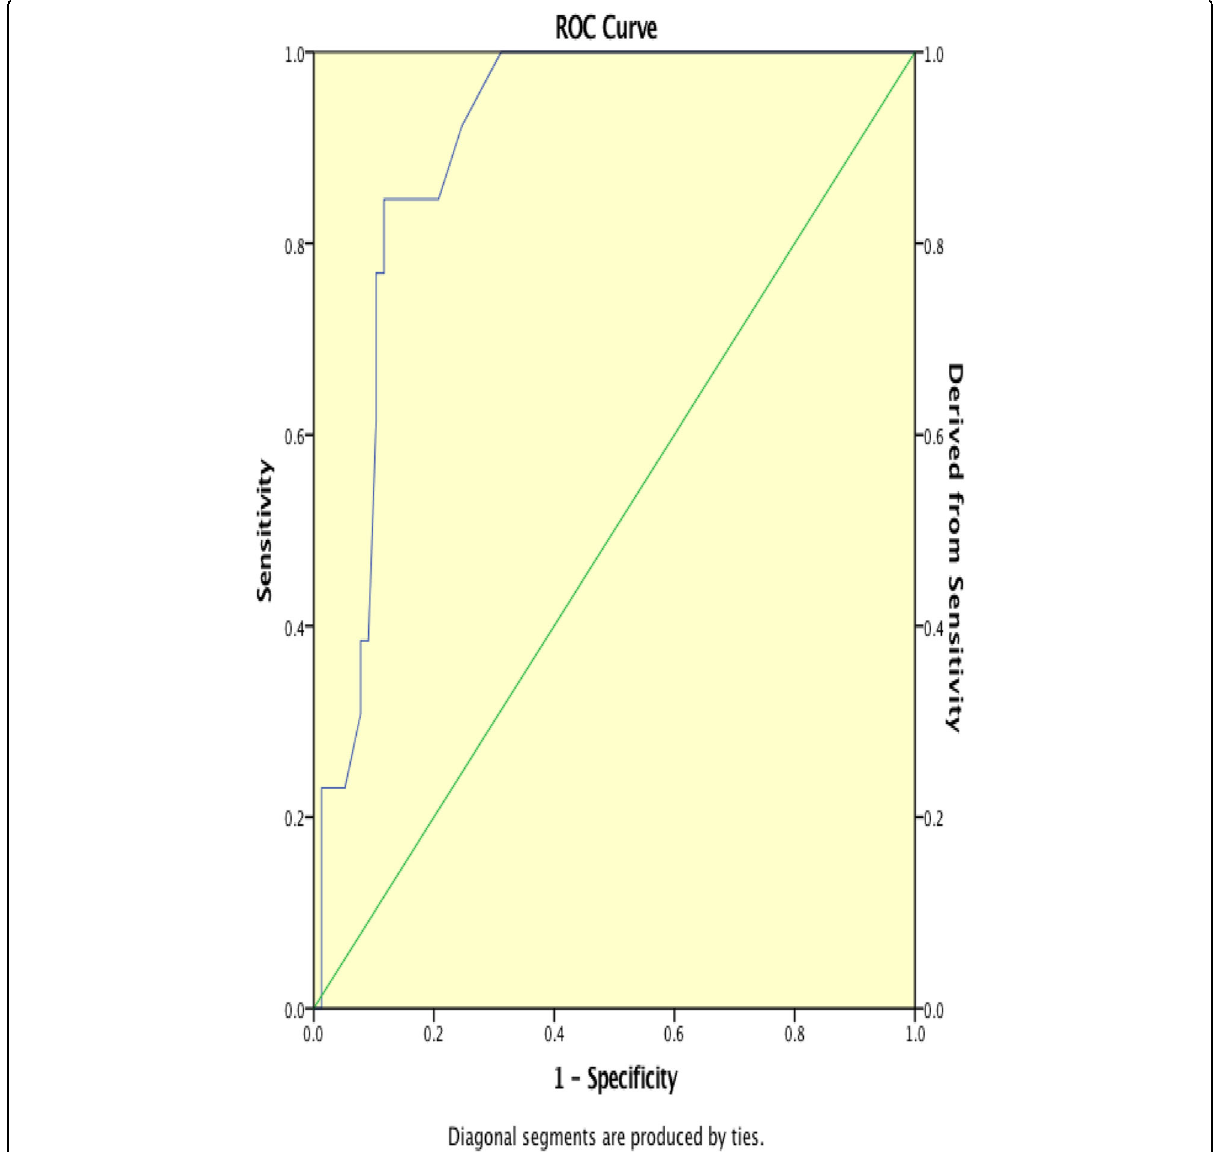
Fig. 4 ROC displaying specificity and sensitivity of IL-6 in predicting recurrence. Receiver operating characteristics (ROC) with area under the curve (AUC) analysis was used to test the specificity and sensitivity of IL-6 testing to predict recurrence. AUC value was 0.9 indicating both strong test specificity and sensitivity in predicting recurrence with a P value of